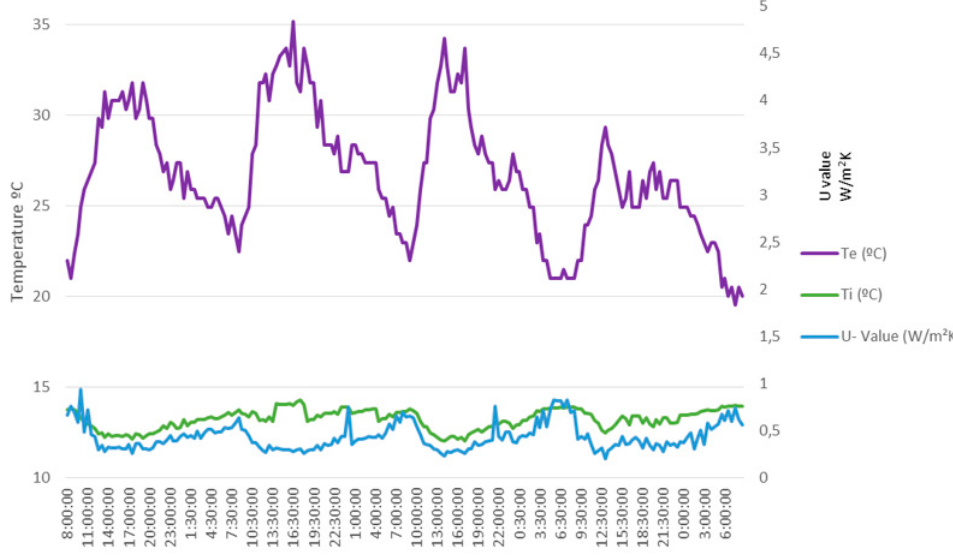
Figure 11. Measures taken with the heat flow metre after the energy retrofitting.